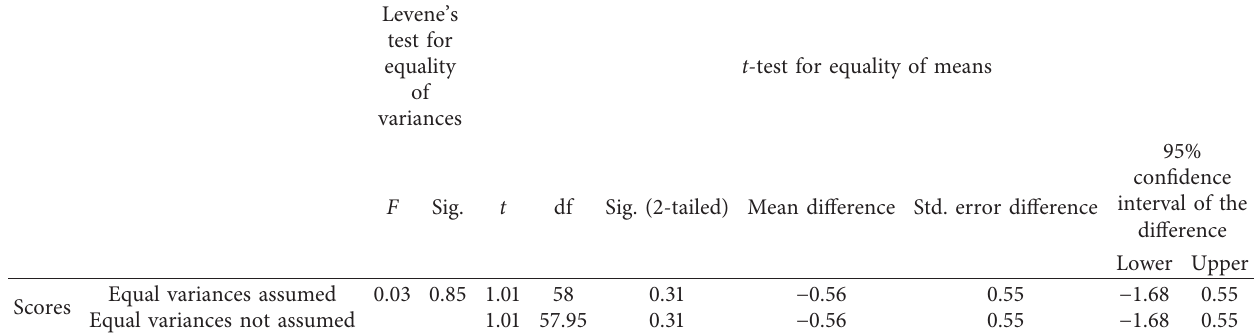
Table 2: Independent-samples t -test (reading comprehension pretest).